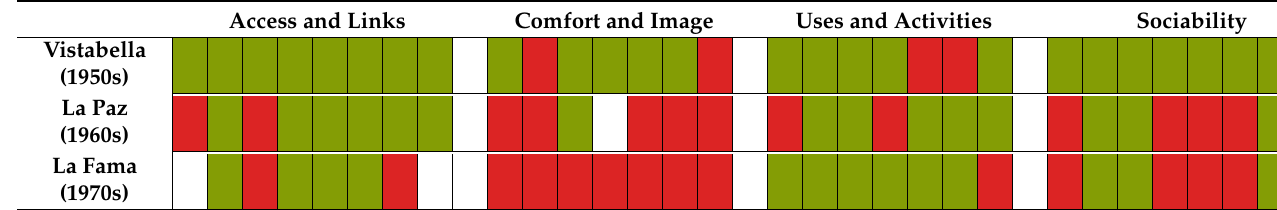
Table 4. Project for Public Spaces indicators.